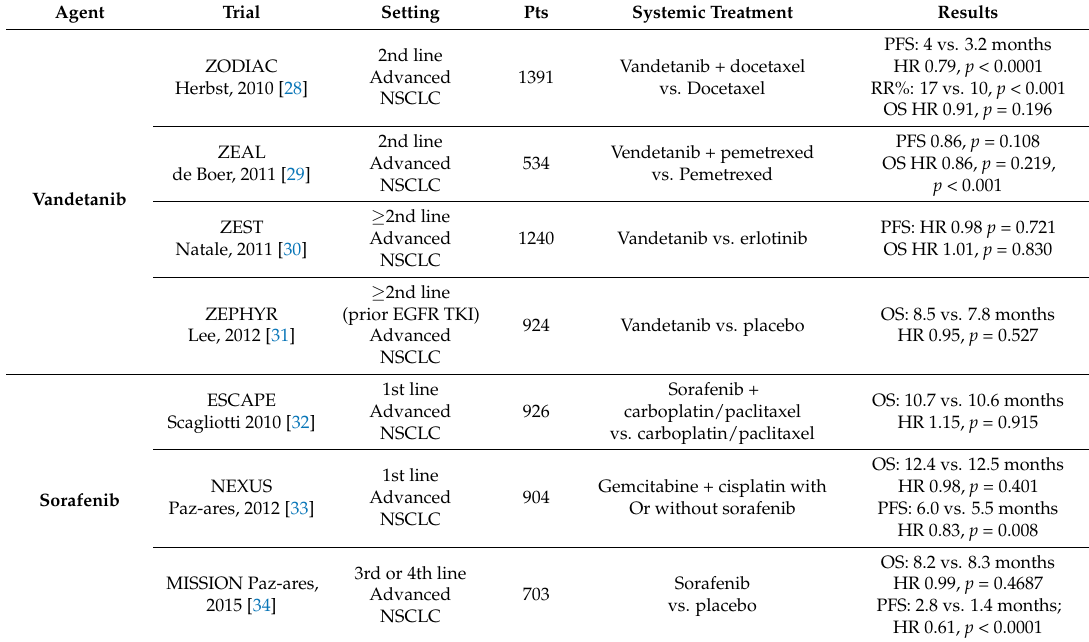
Table 2. Randomized phase III clinical studies with VEGF receptor (VEGFR) tyrosine kinase inhibitors (TKIs) and VEGF-trap in